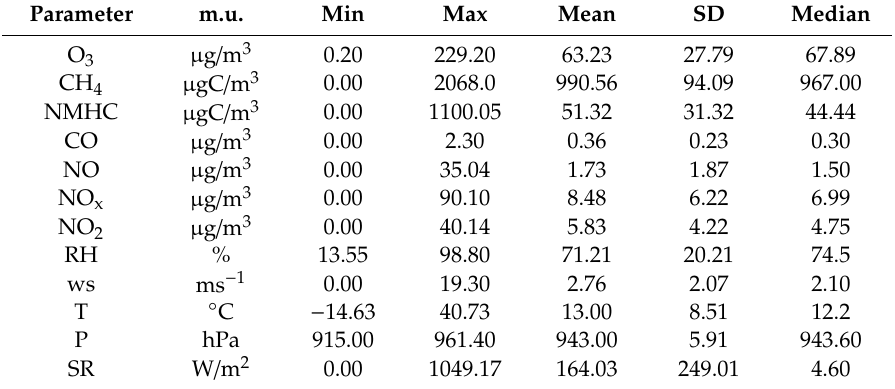
Table 1. Statistical summary of hourly data of O 3 , its precursors and meteorological parameters registered at the MdB monitoring station from January 2016 to December 2018. Legend: SD = standard deviation; m.u. = measurement units. (O 3 : ozone; CH 4 : methane; NMHC: non-methane volatile organic compounds; CO: carbon monoxide; NO: nitrogen monoxide; NO x : nitrogen oxides; NO2: nitrogen dioxide; RH: relative humidity; ws: wind speed; T: temperature; P: atmospheric pressure; SR: solar